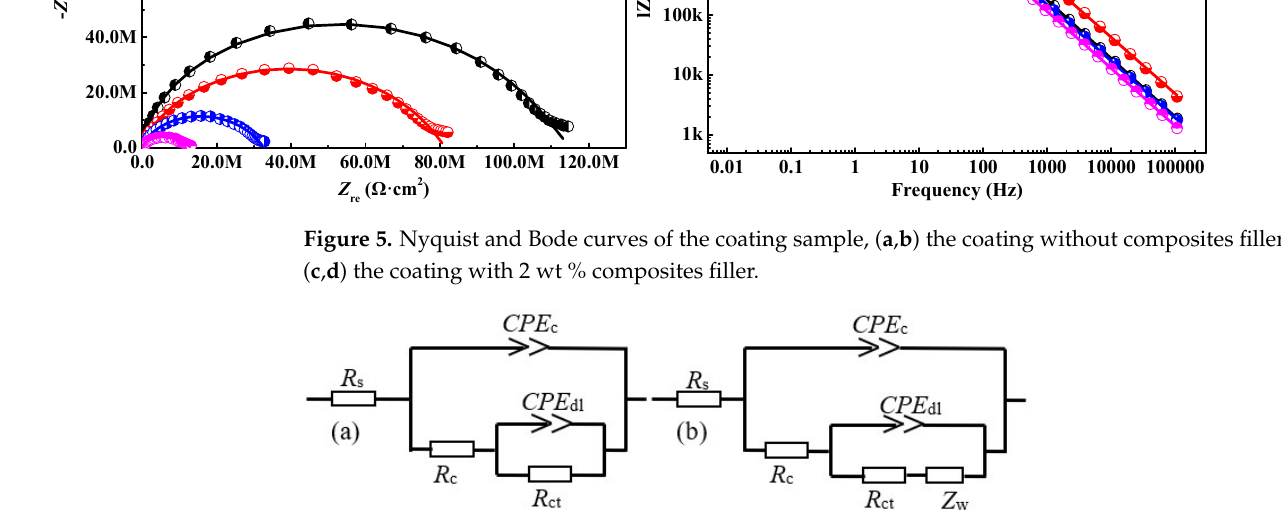
Figure 6. The equivalent electrical circuit for the coating samples in different stages.